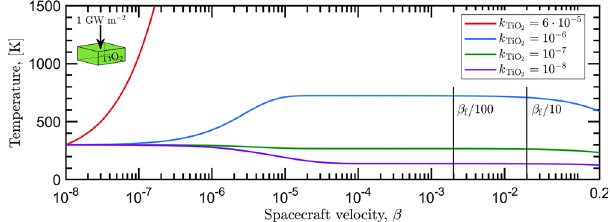
Fig. 7 TiO 2 single layer lightsail temperature evolution during the acceleration phase with initial temperature at T 0 = 300 K. The temperature evolution is calculated for different values of the extinction coef fi cients. Here the irradiance is I 0 = 1 GW m − 2